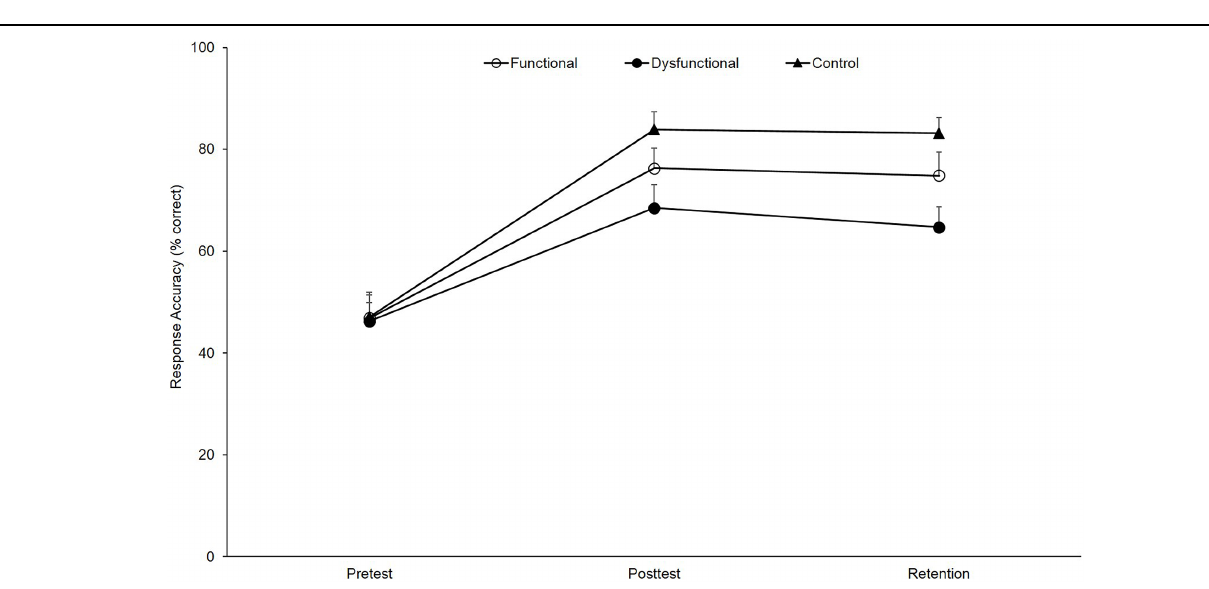
FIGURE 6 | Response accuracy ( M and SE , in % correct) as a function of group (functional, dysfunctional, and control) and test (pre-test, post-test, and